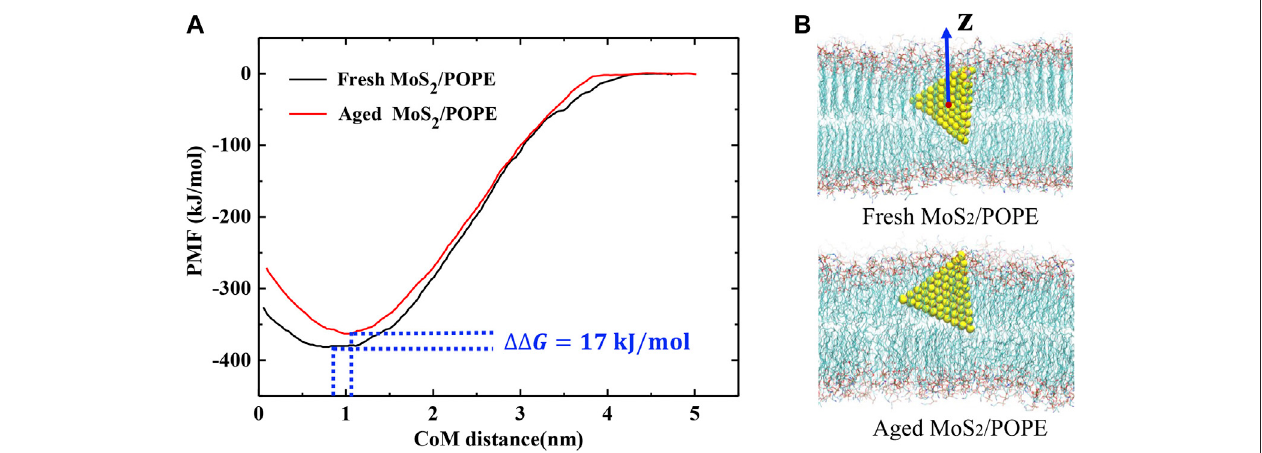
FIGURE 5 | Free energy changes of the MoS 2 nanosheets insertion into the POPE lipid membrane. (A) Potential of mean force (PMF) curves for insertion of the fresh/aged MoS 2 nanosheets calculated from umbrella sampling simulations. (B) The representative conformation of the fresh/aged MoS 2 nanosheets interacting with the POPE lipid membrane corresponding to the potential wells.